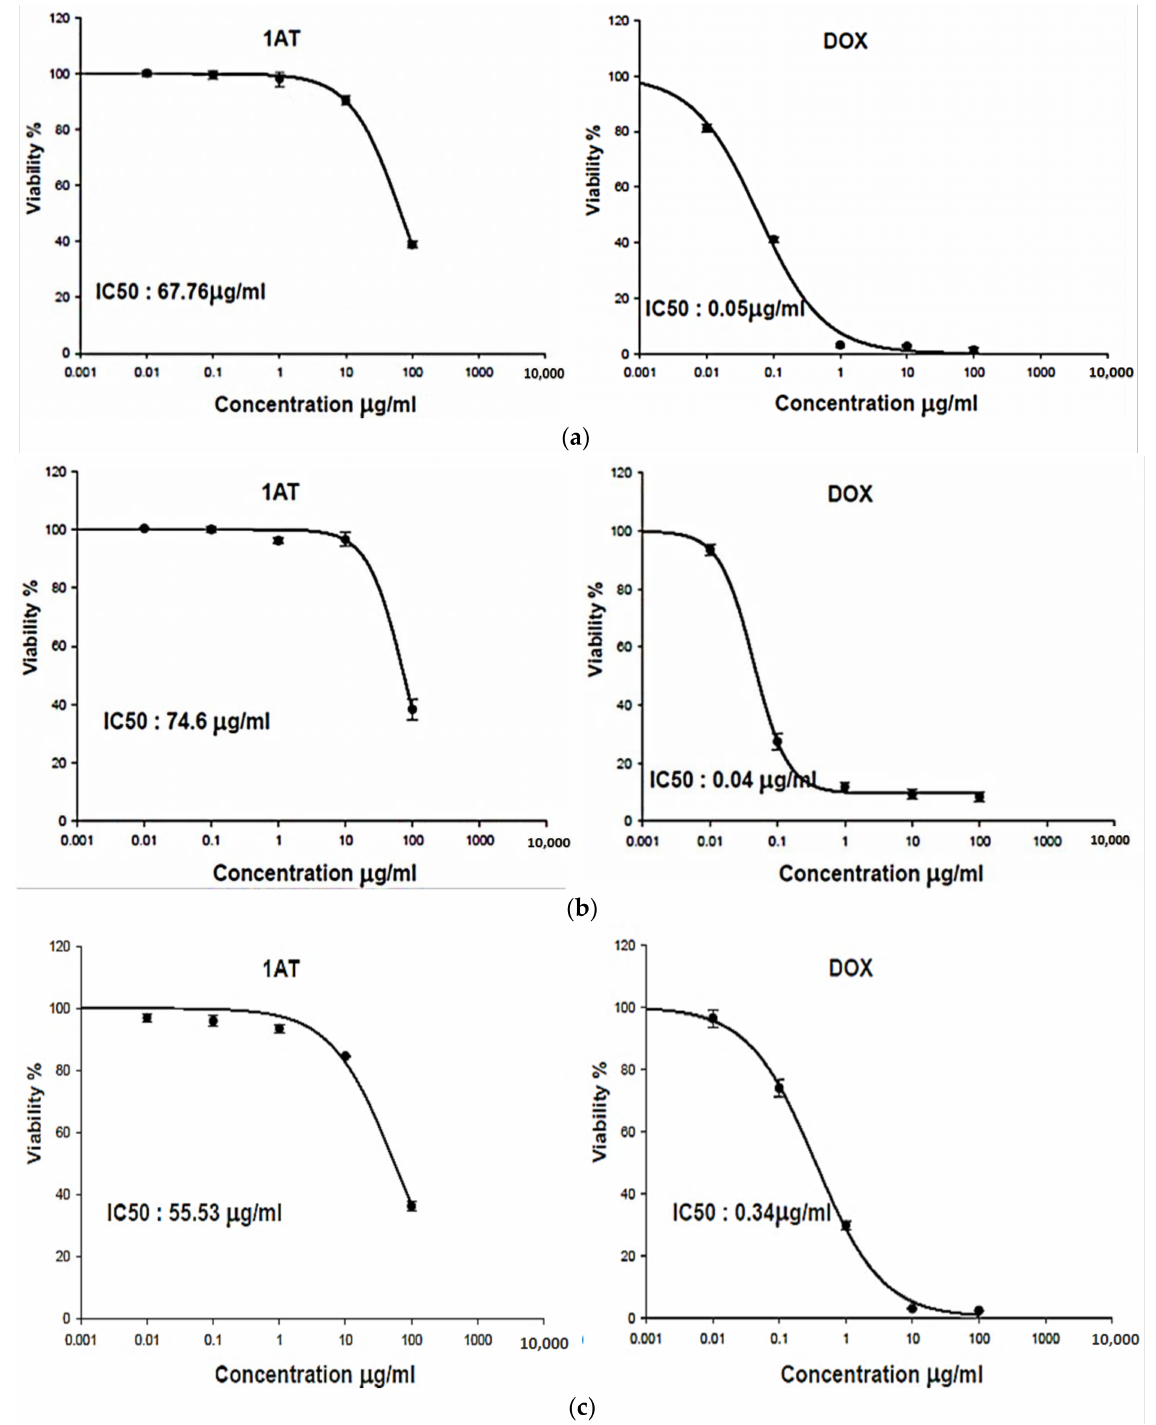
Figure 1. IC 50 dose–response curves of cytotoxic activities of A. tenuissima extract and doxorubicin against ( a ) HeLa cell line, ( b ) SKOV-3 cell line, ( c ) MCF-7 cell